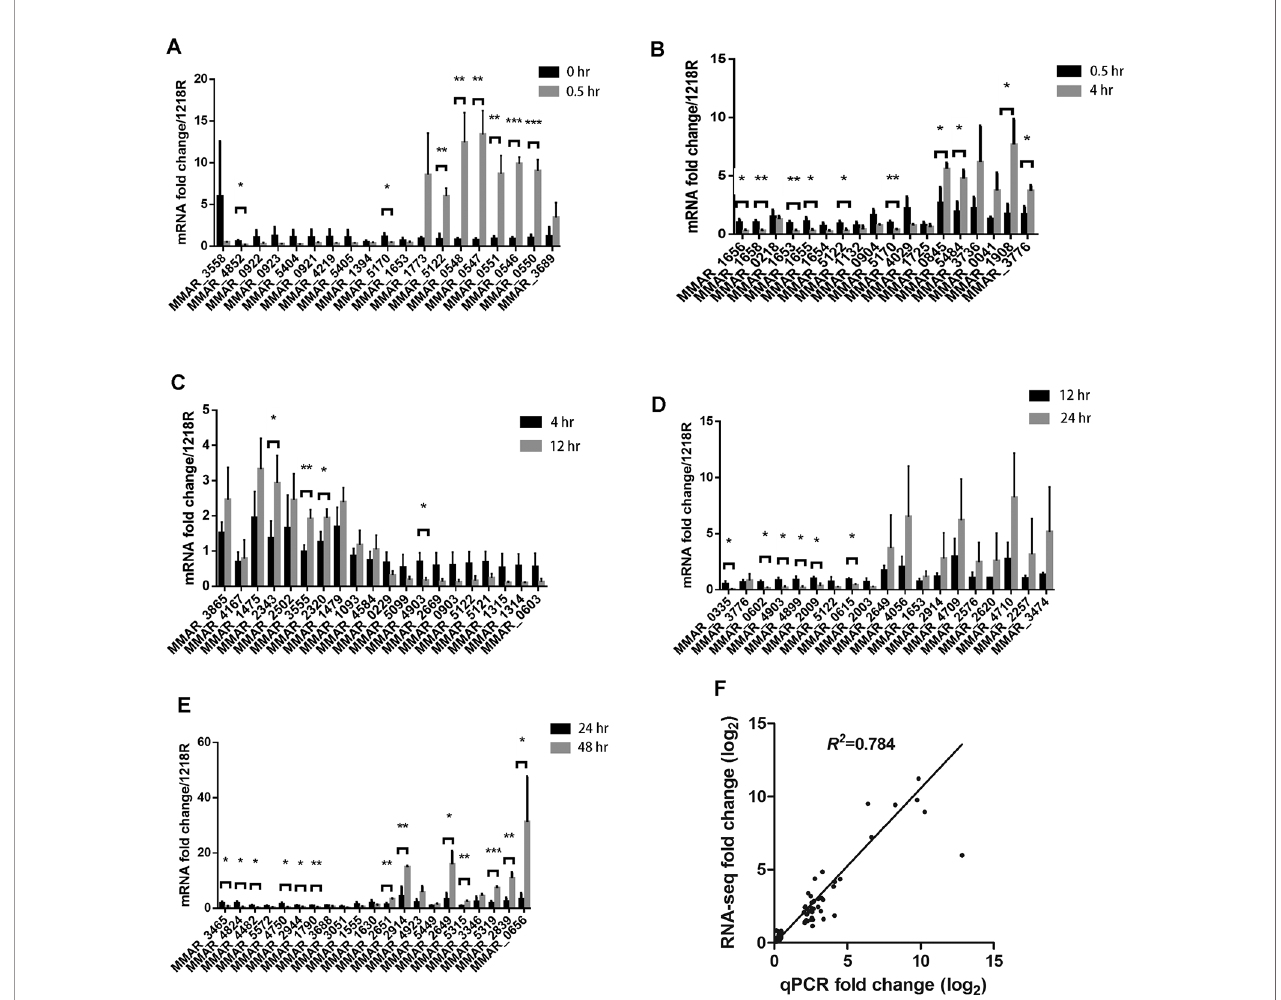
FIGURE 4 | qRT-PCR results. (A – E) Approximately 20 genes from each period were selected and analyzed by qRT-PCR. * p < 0.05; ** p < 0.01; and *** p < 0.001. (F) Scatter plot of RT-PCR data of all genes analyzed in (A – E) , comparing them to RNA-seq data of the same